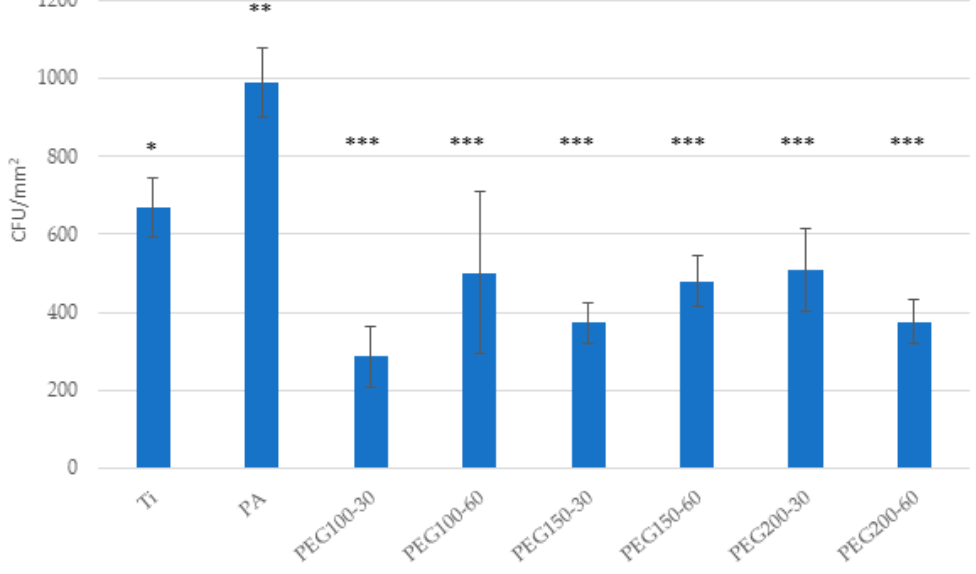
Figure 10. Bacterial adhesion on Ti, PA and PEG samples of Spectrococcus sanguinis. Asterisks indicated with the same symbol have no statistically significant difference between them ( p > 0.05).